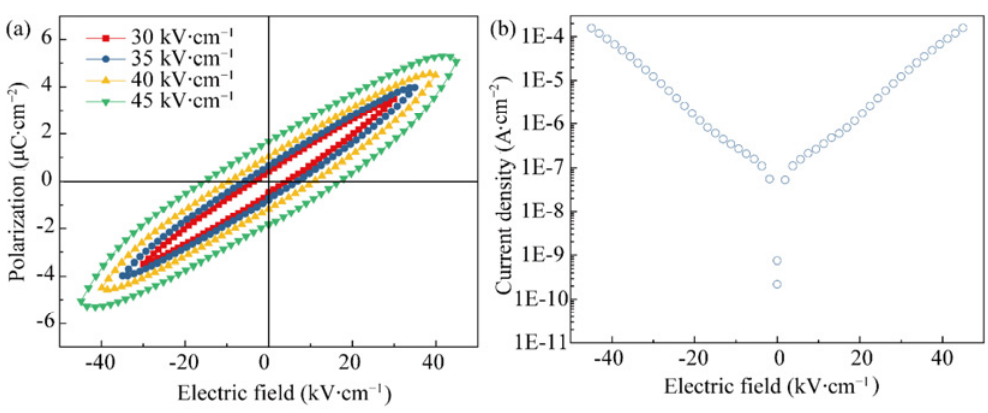
Fig. 9 Ferroelectric properties of high-entropy BLYDTFO ceramics at 10 Hz and room temperature: (a) P at various E and (b) current density loop vs. E .